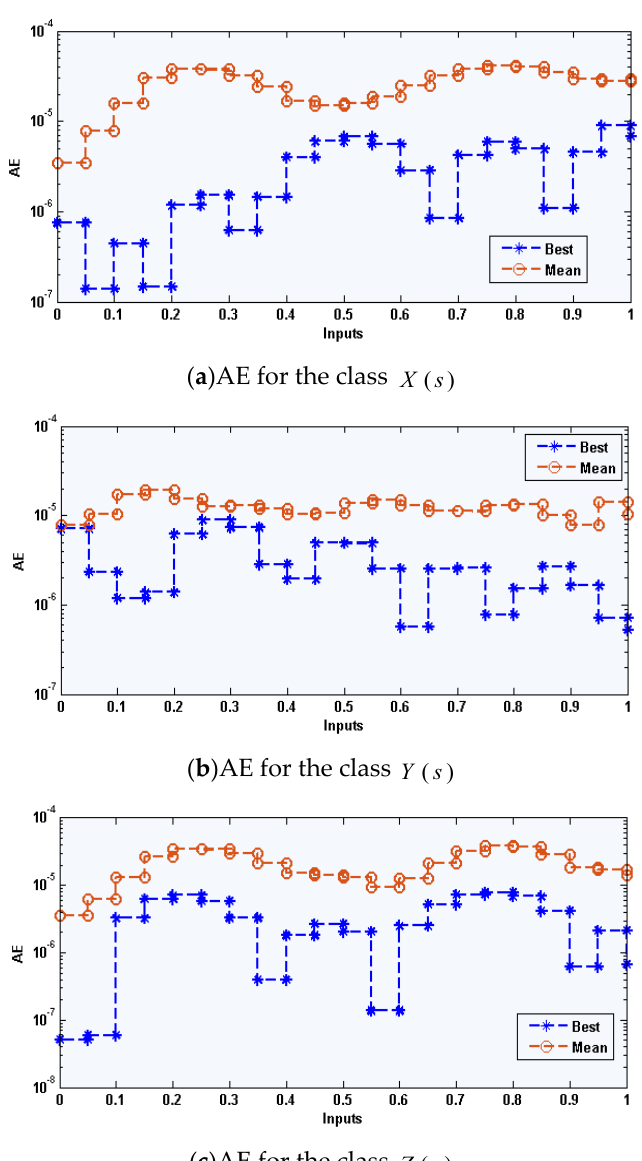
Figure 2. Best values of the weights vectors and results comparison to solve the environmental and economic nonlinear model.